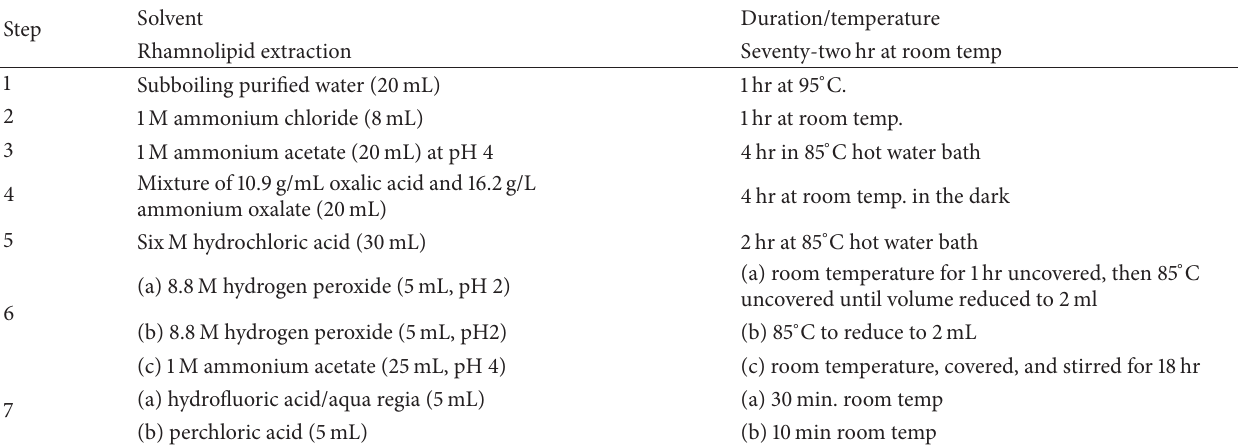
Table 2: The procedure followed for the sequential extraction paired with the rhamnolipid extraction. The table includes the solvent utilized and the duration and temperature of the agitation for the